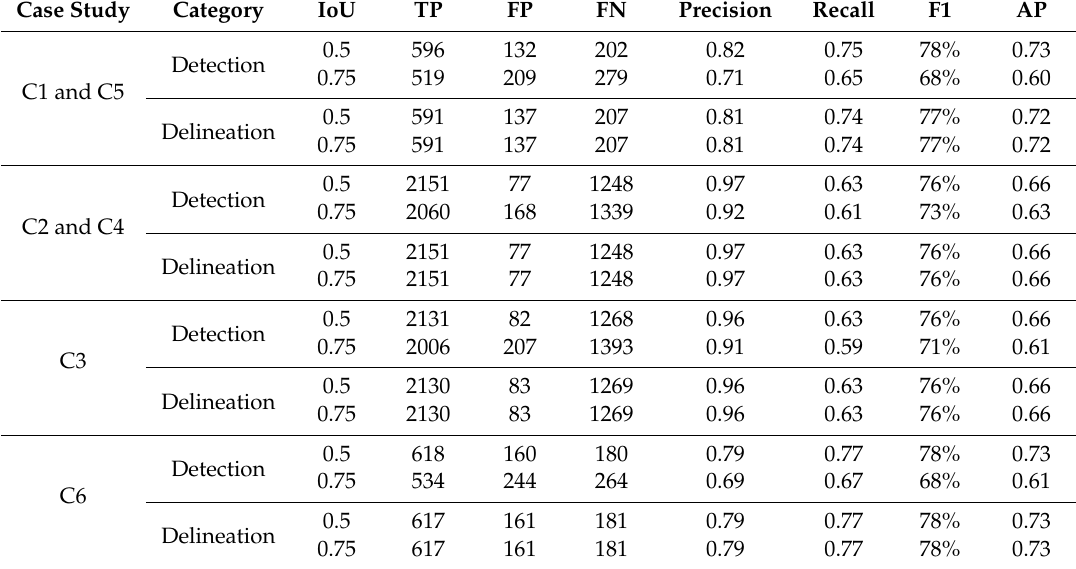
Table 4. Comparison of results of di ff erent processing combinations of quantitative assessment based on model testing datasets.